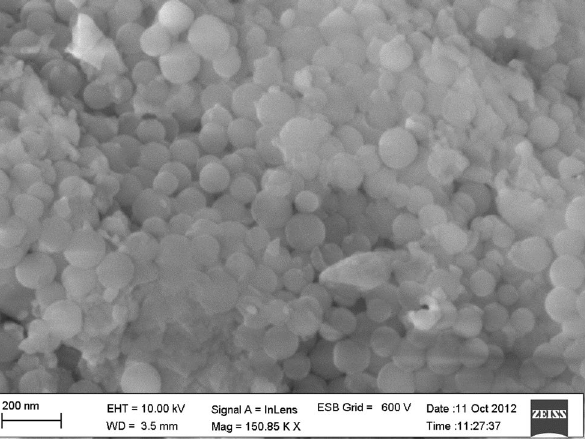
Figure 2. FESEM image of silica nanoparticles where the spherical morphology is clearly evident. The average size of the particles is around 60